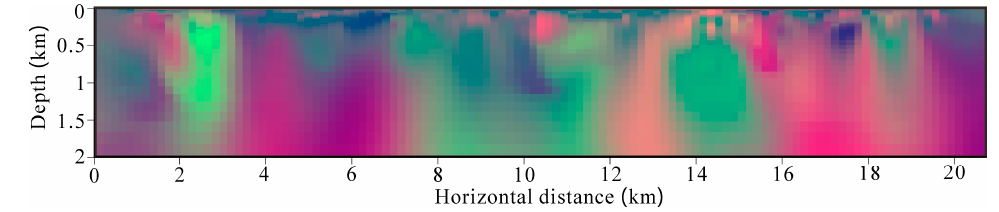
Figure 16. The RGB composite image of the elastic-net joint inversion.